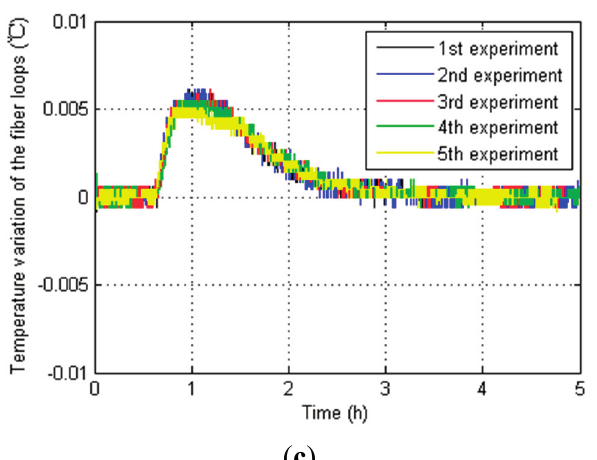
Figure 9. Relevant test results from NO.3 IFOG. ( a ) IFOG outputs; ( b ) Fiber loop temperature variation ∆ T ; ( c ) Temperature product term T × ∆ T